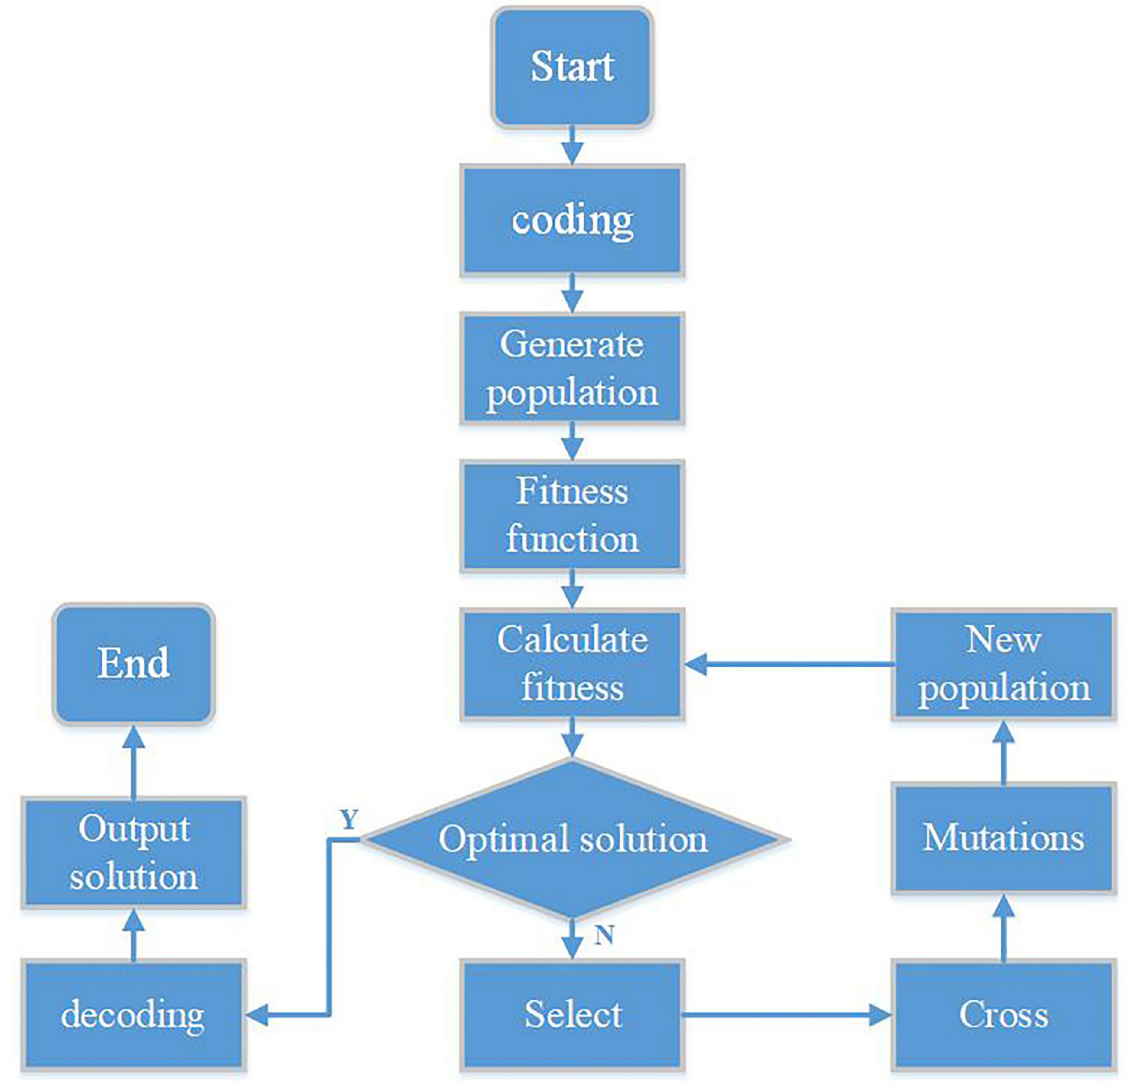
Fig 12. Flow chart of genetic